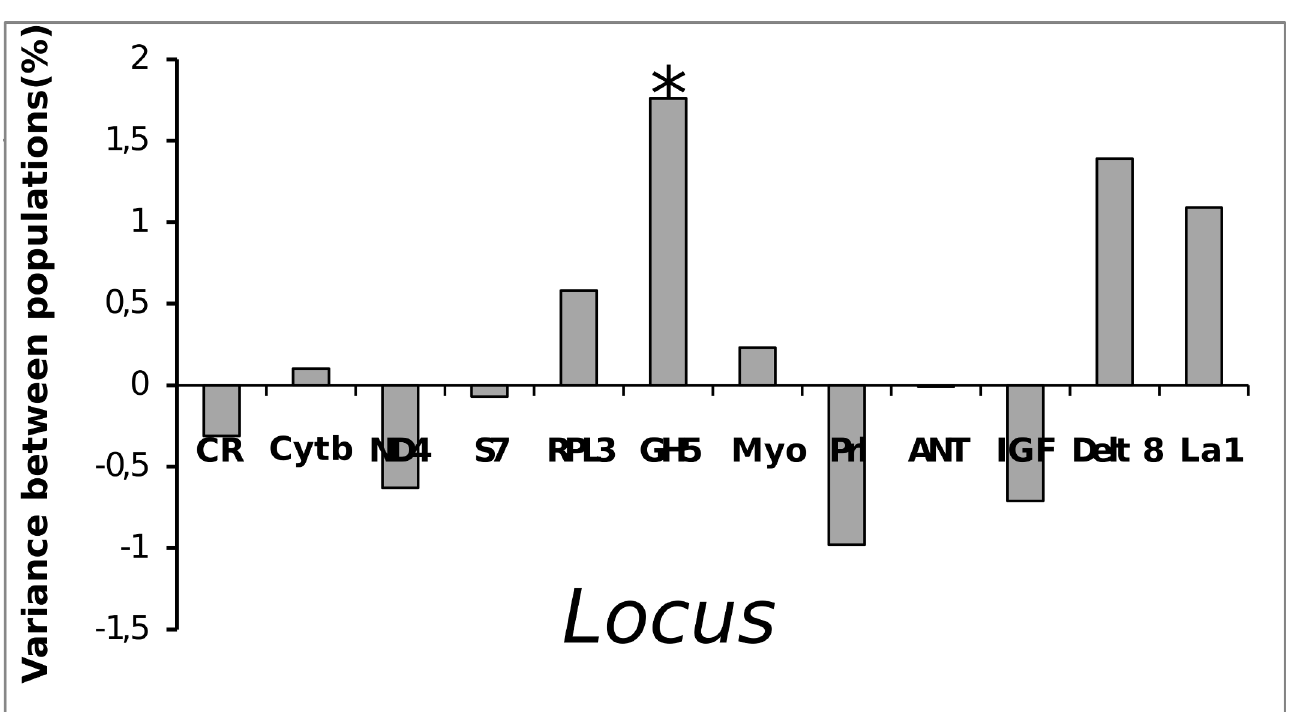
Fig 4. Proportion of the variance (in percentage) between populations when all the sampled locations are grouped into a single cluster. * - Φ st value is significant (p < 0.05).